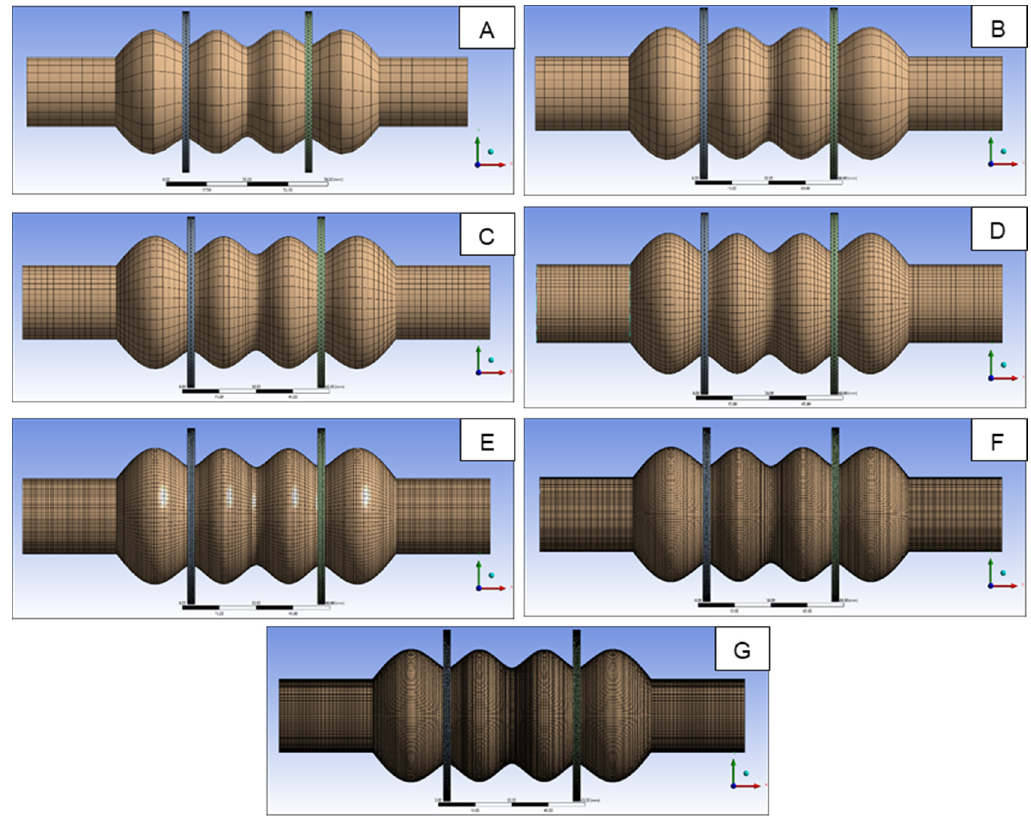
Figure 6. FE models analyzed to validate the mesh size adopted in numerical simulations. Processes 2020 , 8 , x FOR PEER REVIEW Table 2. FE size of the different models reported in Figure 6.